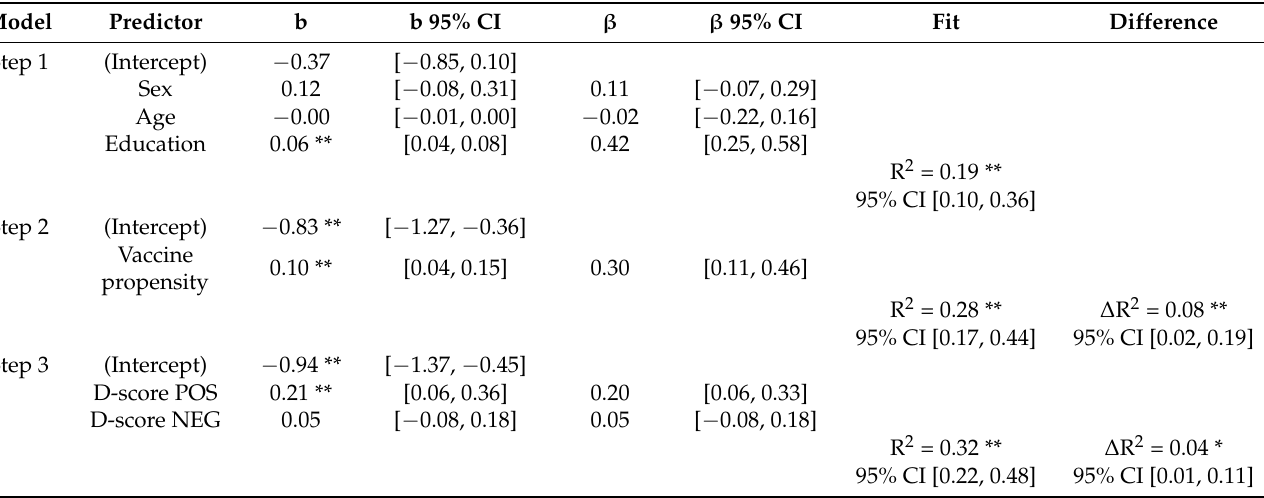
Table 1. Regression results using vaccine behavior as a dependent